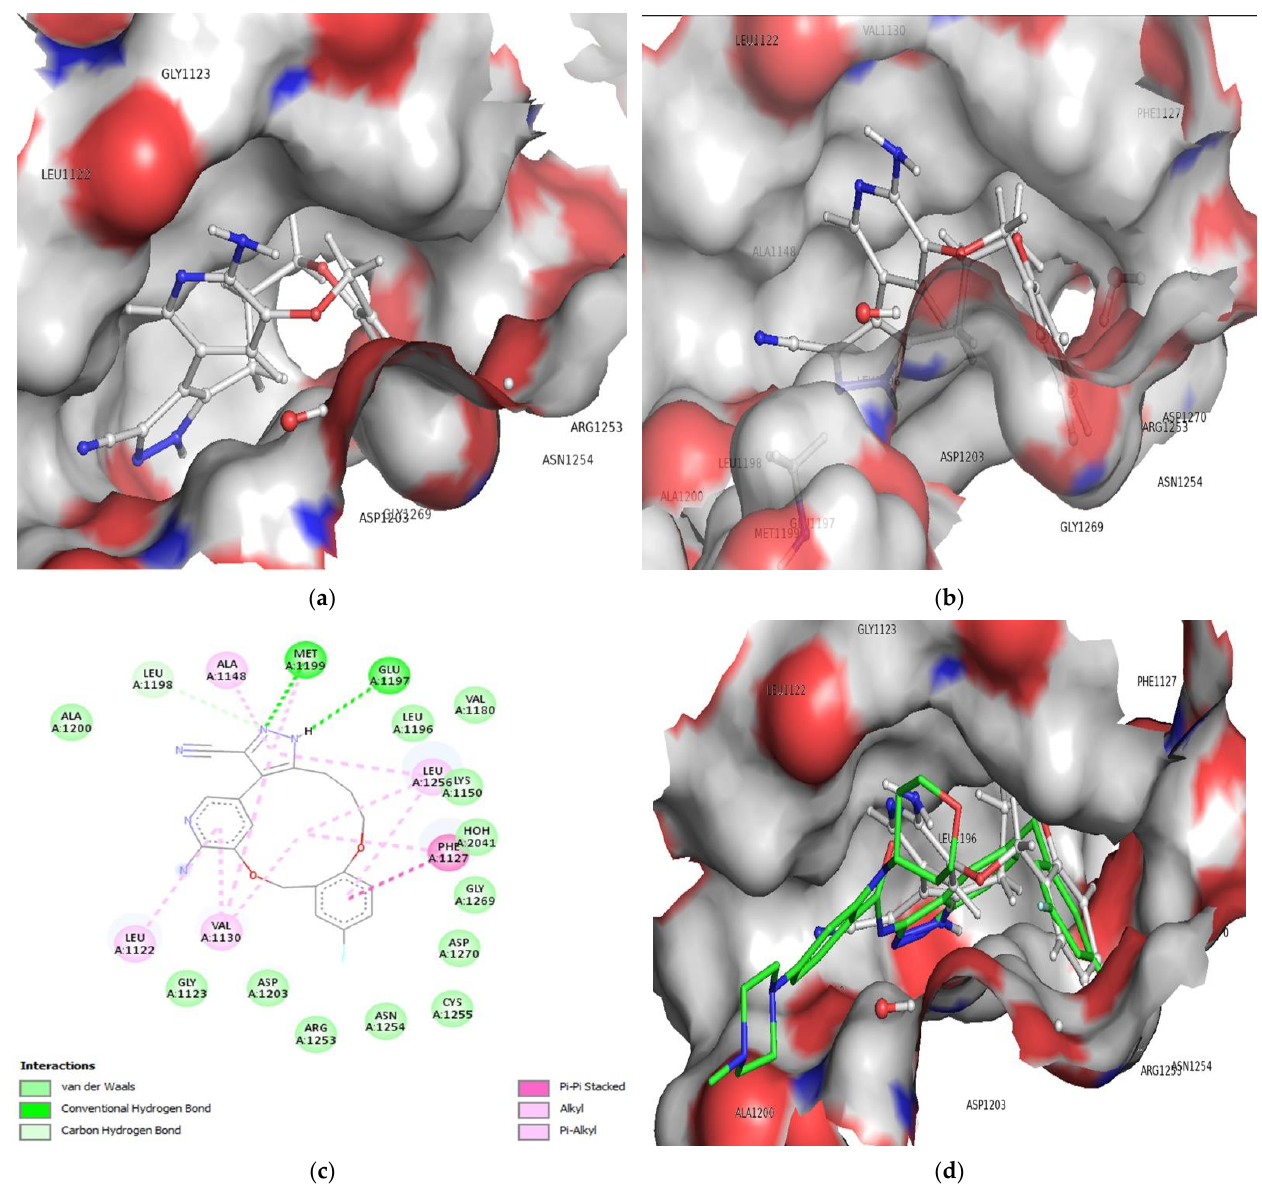
Figure 7. Depiction of alignment of compound 172 within the active site of ALK tyrosine kinase ( a , b ), 2D interaction of compound 172 with ALK tyrosine kinase ( c ) and Superimposed conformation of compound 172 with the pdb 5fto ligand (green colored); Entrectinib ( d ). Table 2. Presentation of docking interactions of the compound 172.